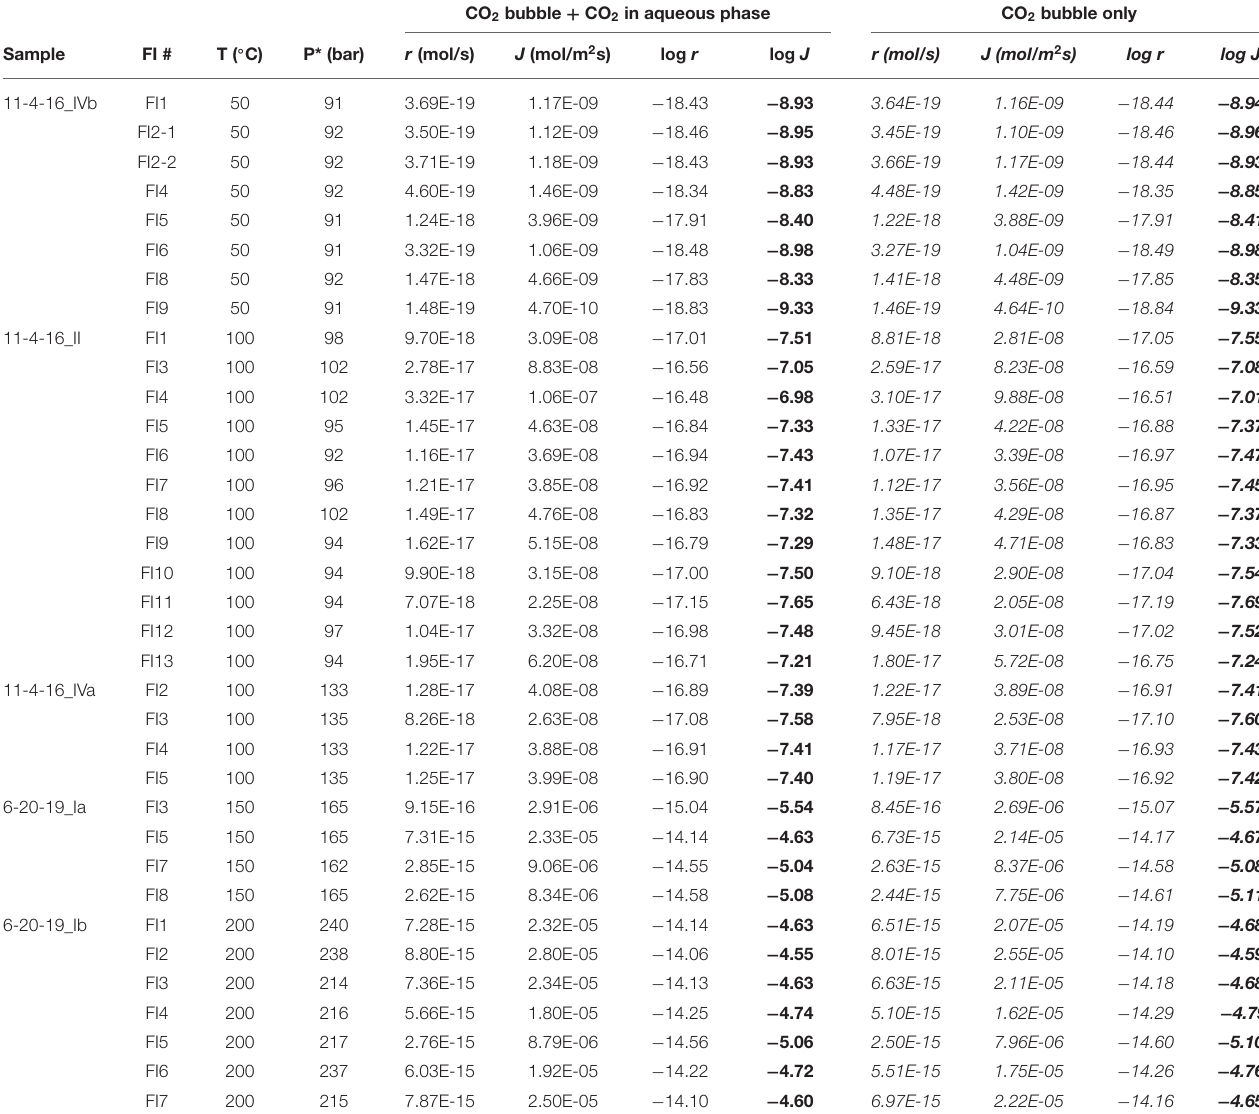
TABLE 2 | Reaction rates ( r , mol/s) and fluxes ( J , mol/m 2 s) for each individual